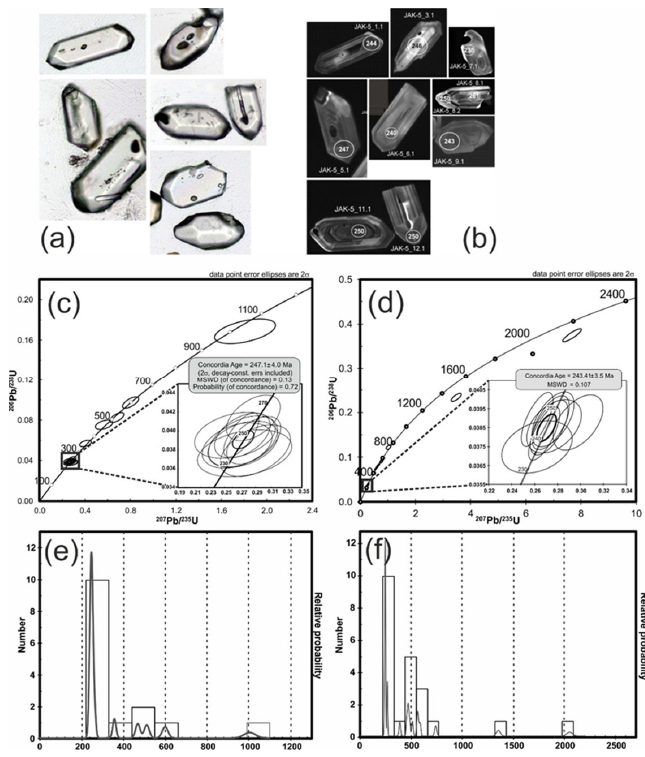
Figure 18. ( a ) Morphology of dated zircon crystals in optical microscope from cherty schist sample JAK-5 (~JAK-1 / 2 sample layer) in Jaklovce cross-section (see Figure 6, Figure 7, Figure 16). ( b )